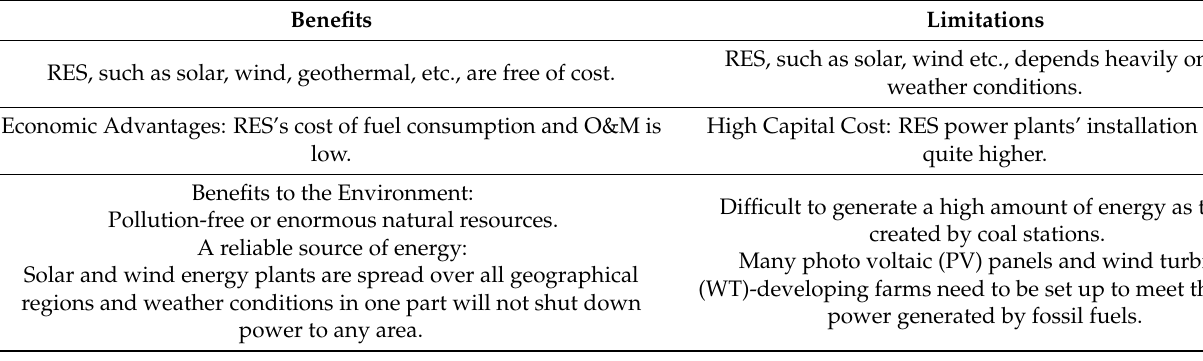
Table 1. Benefits and Limitations of RES [29,30].